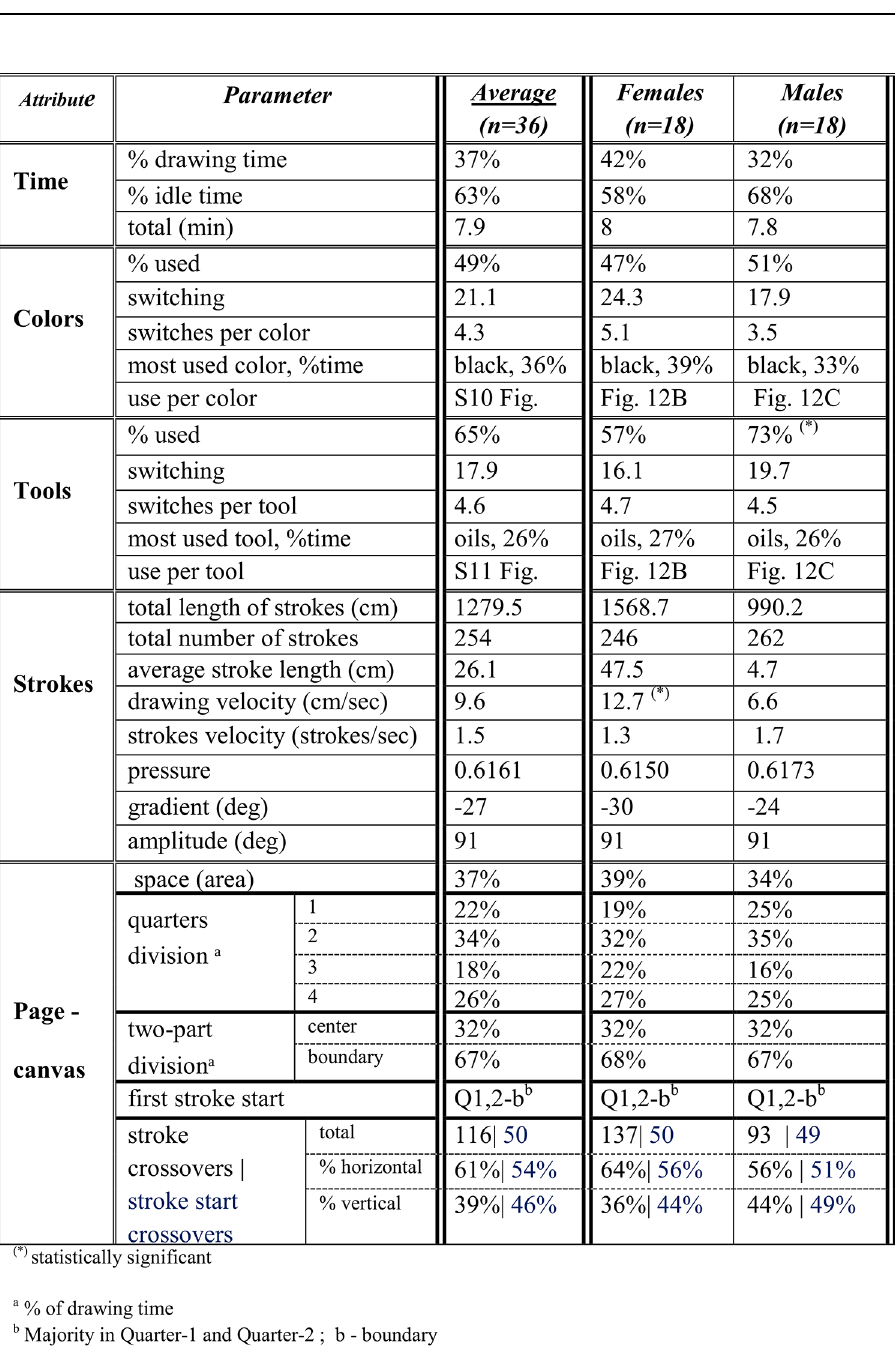
Fig 13. An example of artworks ’ parameters/metrics construction processes comparison of female and male